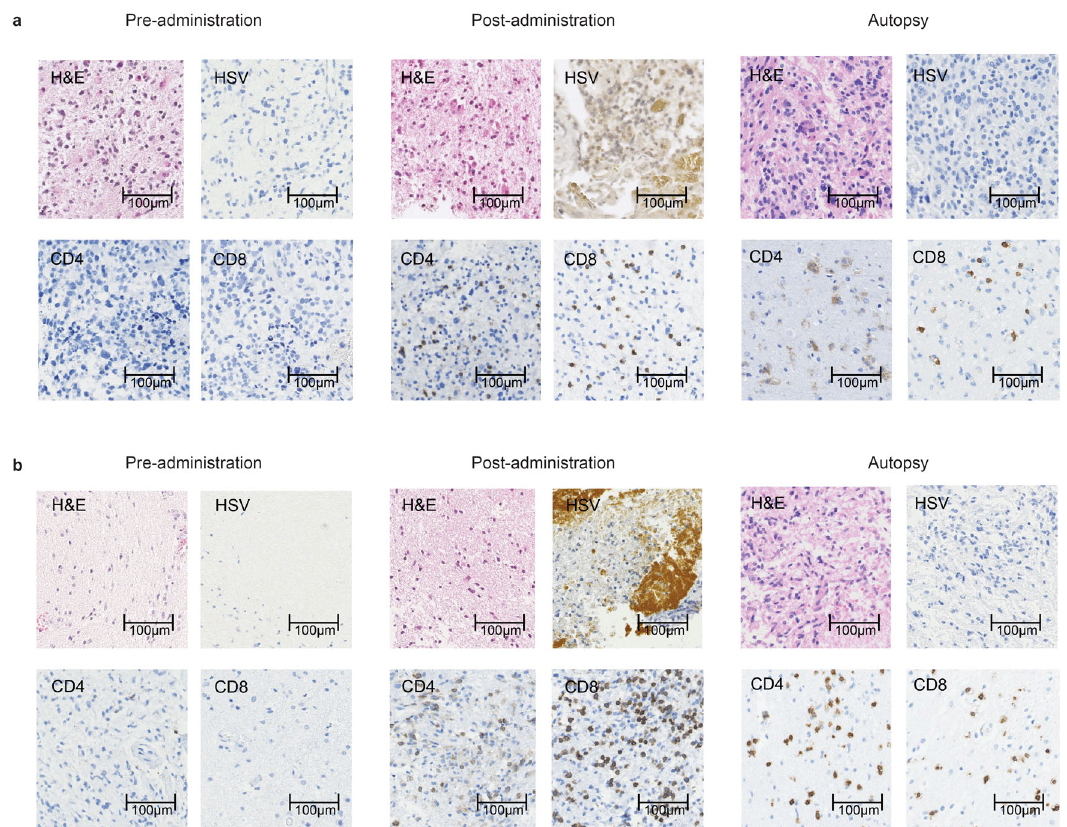
Fig. 5 Histological fi ndings in autopsy cases. a Patient #11: 6.2 months after receiving G47 Δ and b Patient #13: 13.7 months after receiving G47 Δ . Both brain tumor specimens from pre-administration showed negative immunostaining for HSV-1, and very scarce CD4 + and CD8 + T lymphocytes. In fi ltration of CD4 + and CD8 + T lymphocytes and positive HSV-1 immunostaining were observed after G47 Δ administration at the injection site in both cases. Representative of four biopsy specimens. At autopsy, both brain tumor specimens showed viable glioblastoma cells (H&E) together with intratumoral in fi ltration of CD4 + and CD8 + T lymphocytes. The in fi ltration of CD4 + and CD8 + T lymphocytes was shown to persist for >13 months. Autopsy brain tumor specimens were negative for HSV-1 immunostaining. Representative of three tissue samples. NATURE COMMUNICATIONS| (2022) 13:4119